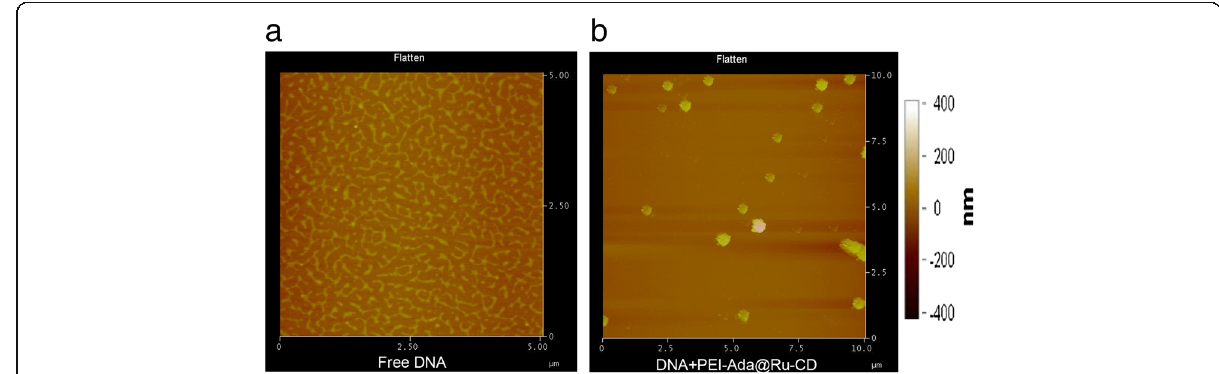
Fig. 5 AFM images of a free pBR322 DNA and b PEI-Ada@Ru-CD with pBR322 DNA at an N/P ratio of 7.2